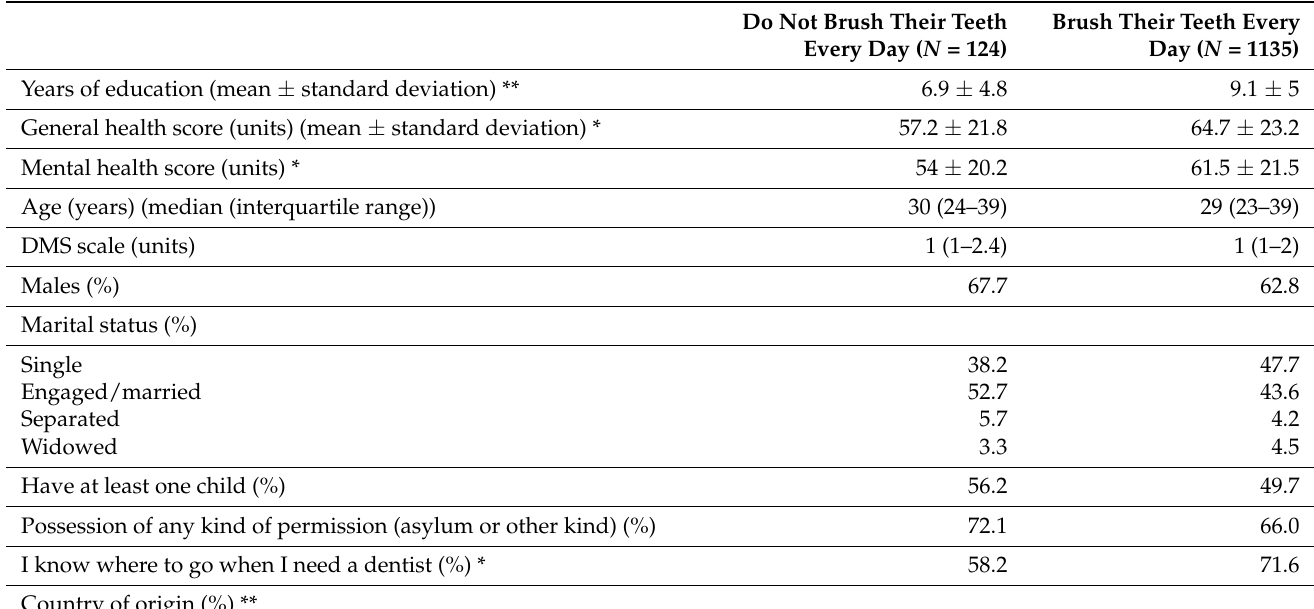
Table 4. Descriptive characteristics and other variables by brushing their